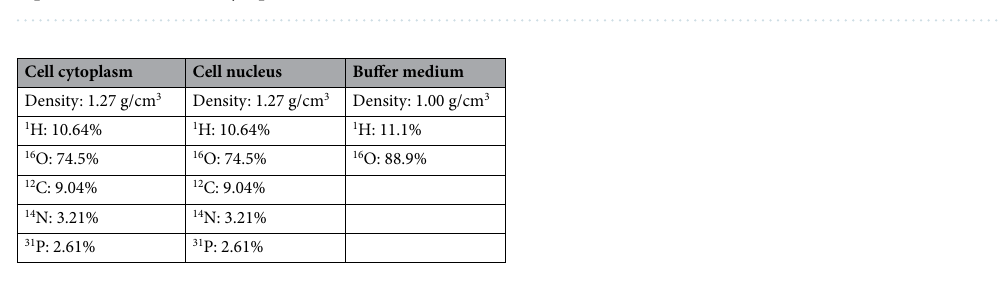
Table 2. Material composition (in weight %) and density of cell cytoplasm, nucleus and buffer medium.